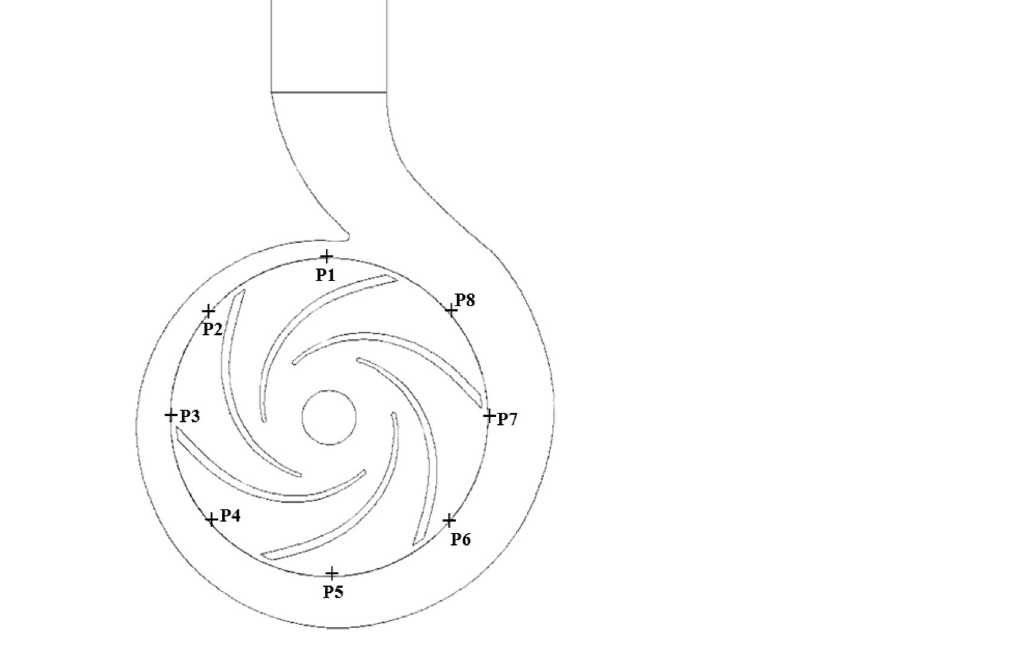
Figure 13. Pressure pulsation monitoring point (pump as